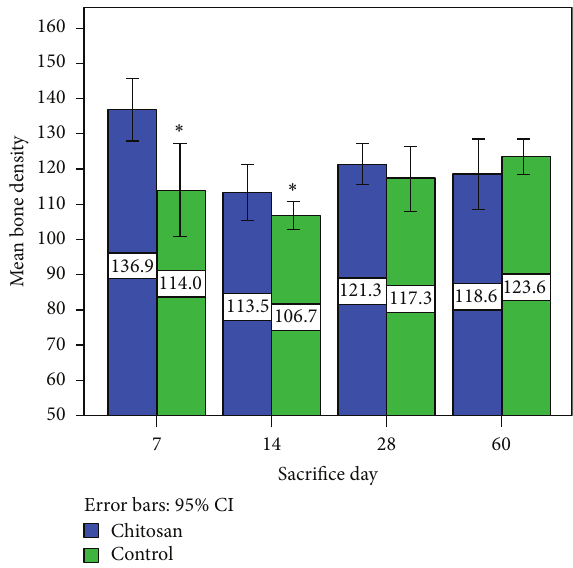
Figure 6: Mean bone density on different days of